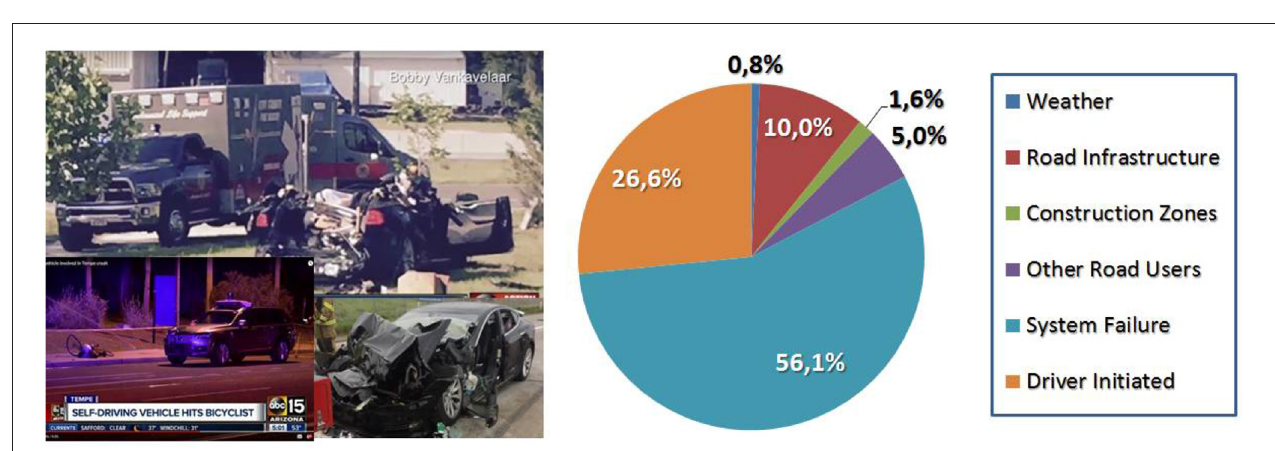
FIGURE 7 | (Top) Automated vehicle crashes and damage locations (Favarò et al., 2017), and (Bottom) disengagement of embedded automated systems in reports from Dixit et al. (2016) and Favarò et al. (2018).